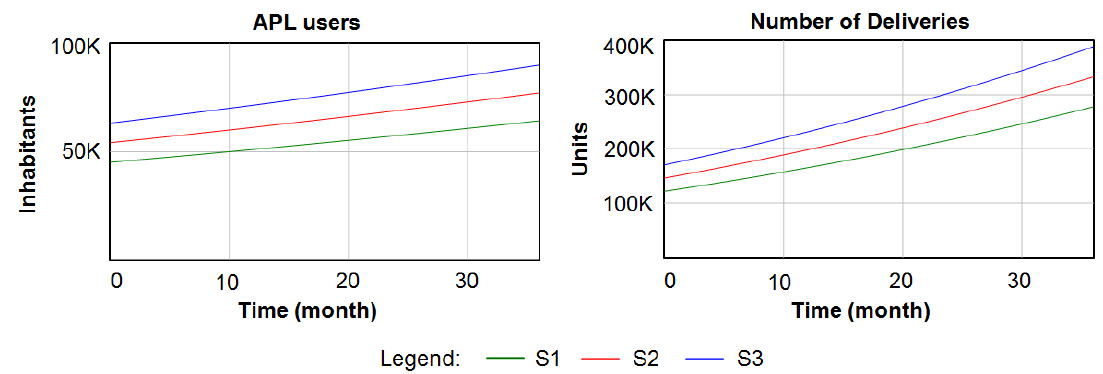
Figure 8. Scenario comparison: APL users ( left ) and number of deliveries ( right